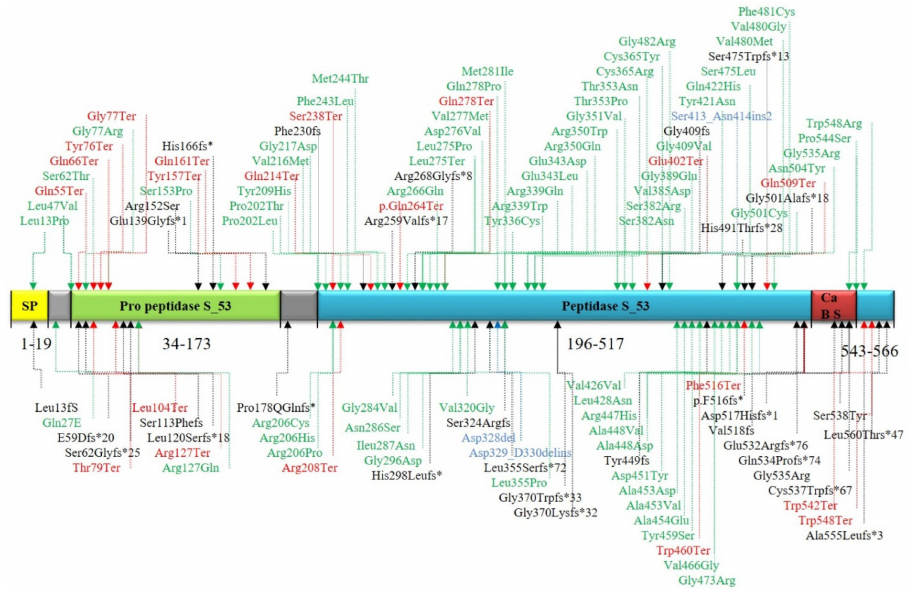
Figure 5. Overview of CLN2–causing TPP1 variants at protein levels. Missense mutations are marked in green while red and black indicate nonsense and frameshift mutations, respectively, and blue indicates insertions and deletions. SP: Signal peptide, Ca BS: Ca 2+ Binding